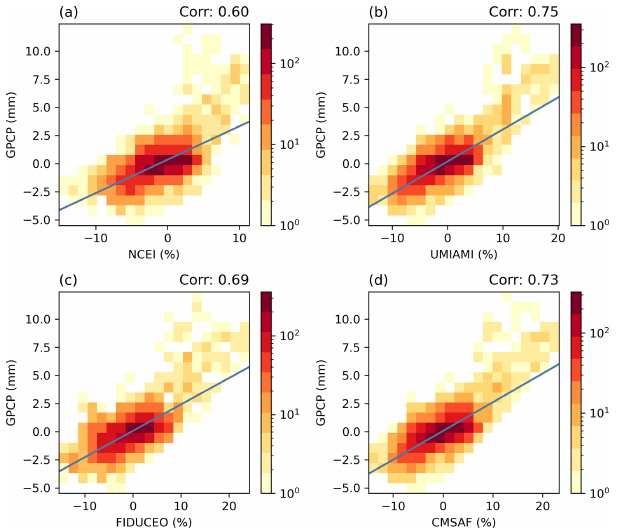
Figure 7. Histograms of UTH anomalies of the four datasets vs. anomalies of GPCP precipitation during the peak 6 months of the 2015–2016 El Niño. The blue line represents the linear regression line. The correlations between UTH anomalies and GPCP precipi- tation anomalies are labeled at the top of the panels.